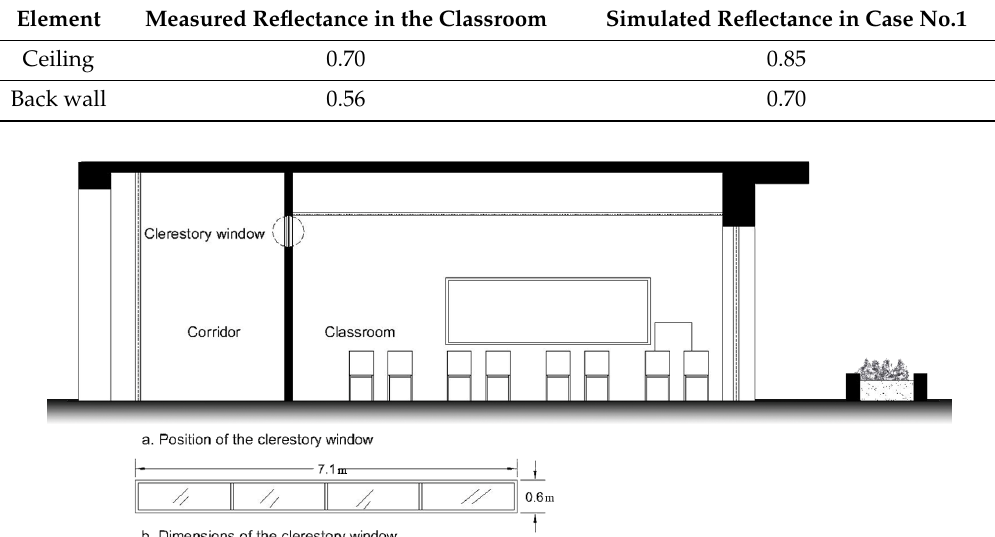
Table 3. Measured and suggested values of materials’ reflectance.